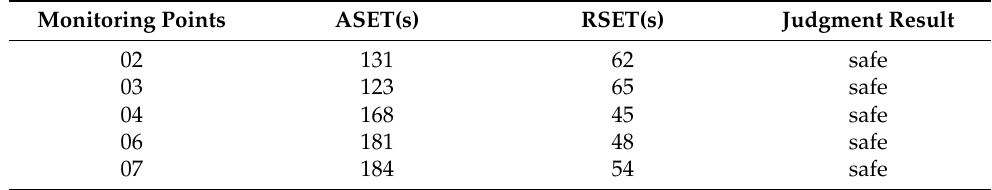
Table 9. Determination of evacuation results of fire monitoring points at the end of the platform. Monitoring